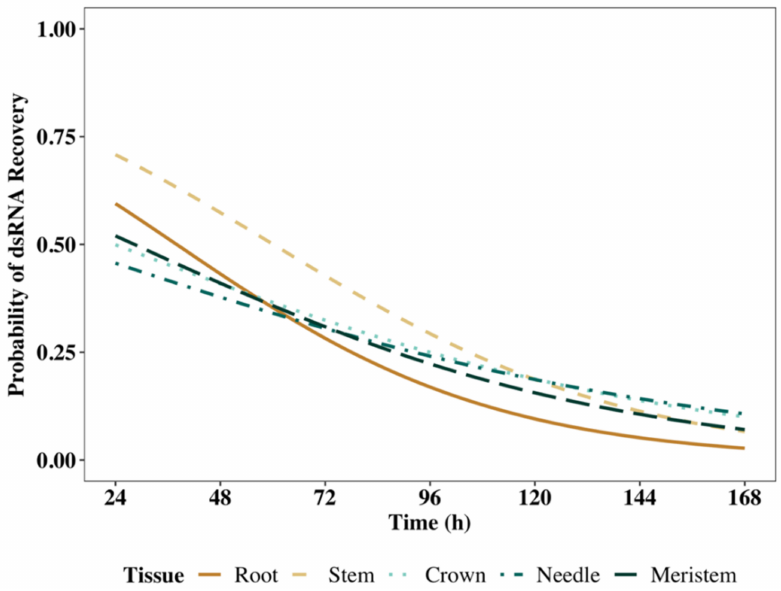
Figure 4. The projected probabilities of dsRNA recovery based on the logistic regression models for each tissue type through time. Models used to generate these projections are summarized in Table